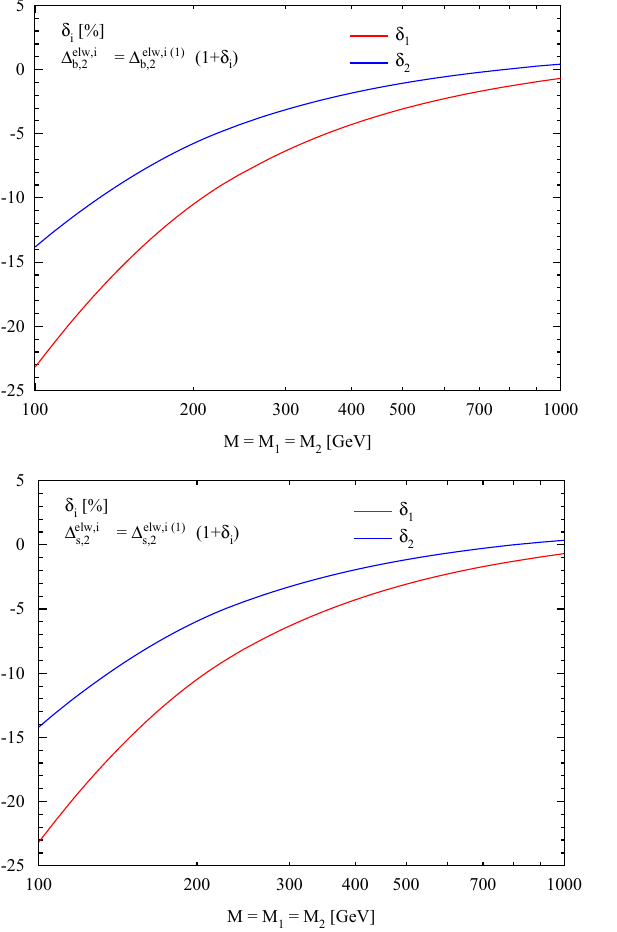
Fig. 9 Radiative corrections to the SUSY–electroweak corrections w, 1 / 2 (cid:9) el w, 1 / 2 (upper plot) and (cid:9) el s (lower plot) as a function of the b gaugino mass parameters M = M 1 = M 2 μ 12 A significant reduction of the dashed one-loop bands 0 .